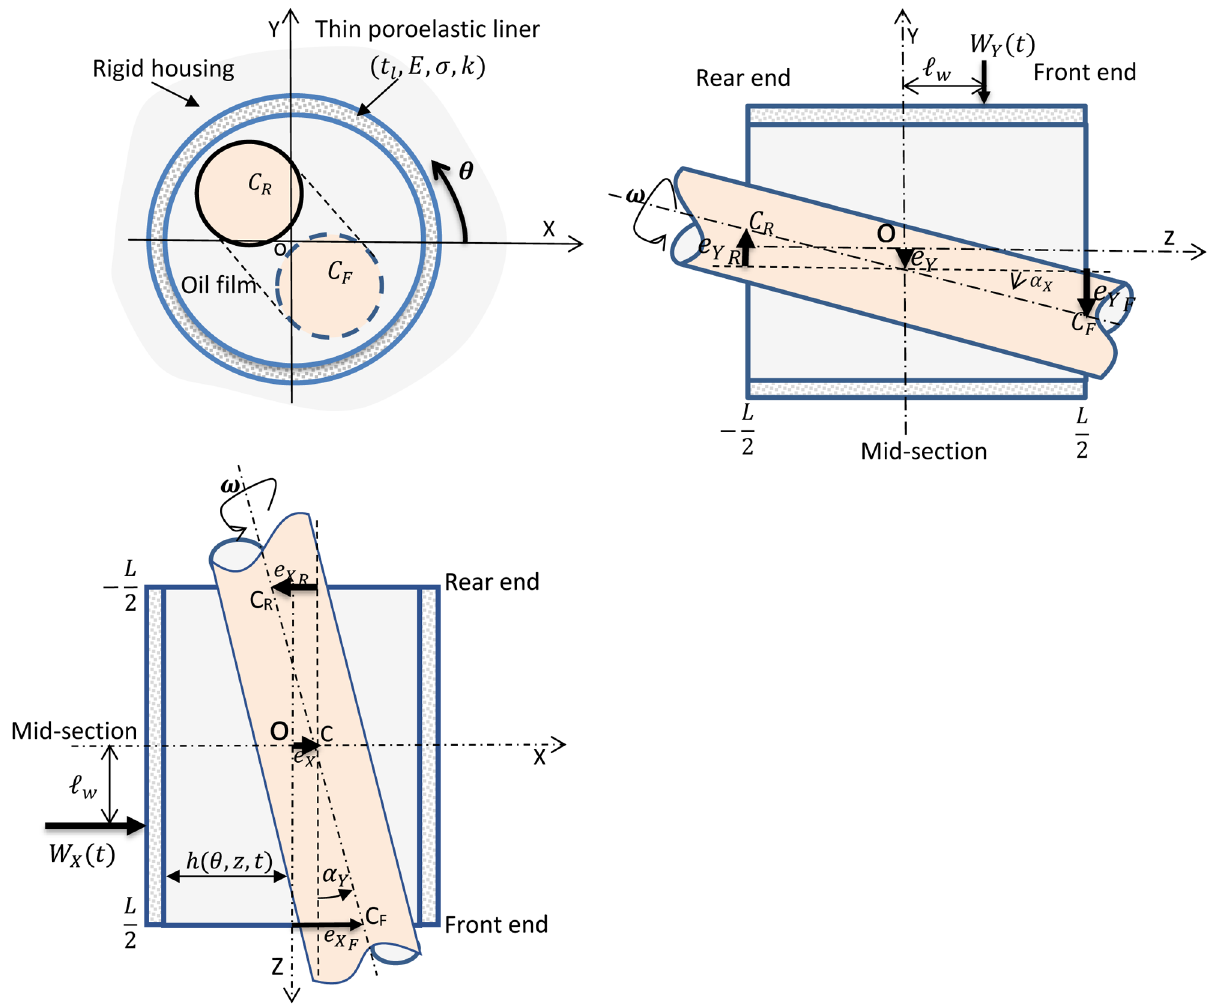
Fig. 2. Geometry of a fi ve degree of freedom main journal bearing, and the system of